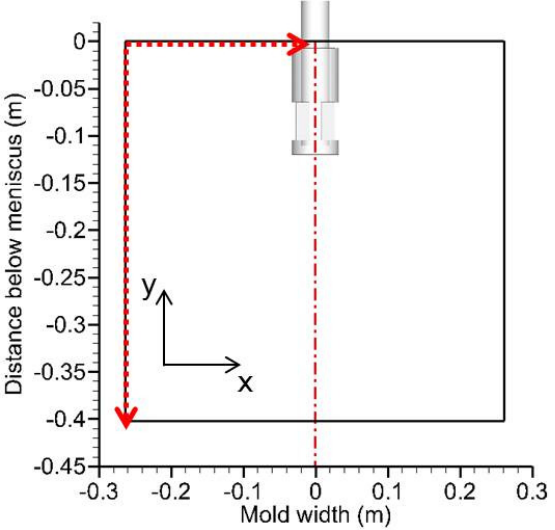
Figure 17. The relationship between the flow rate at a specific point P in the wide slab continuous casting mold and the blowing rate. ( a ) The position of the specific point P and ( b ) the effect of blow- ing rate on the flow rate at point P.